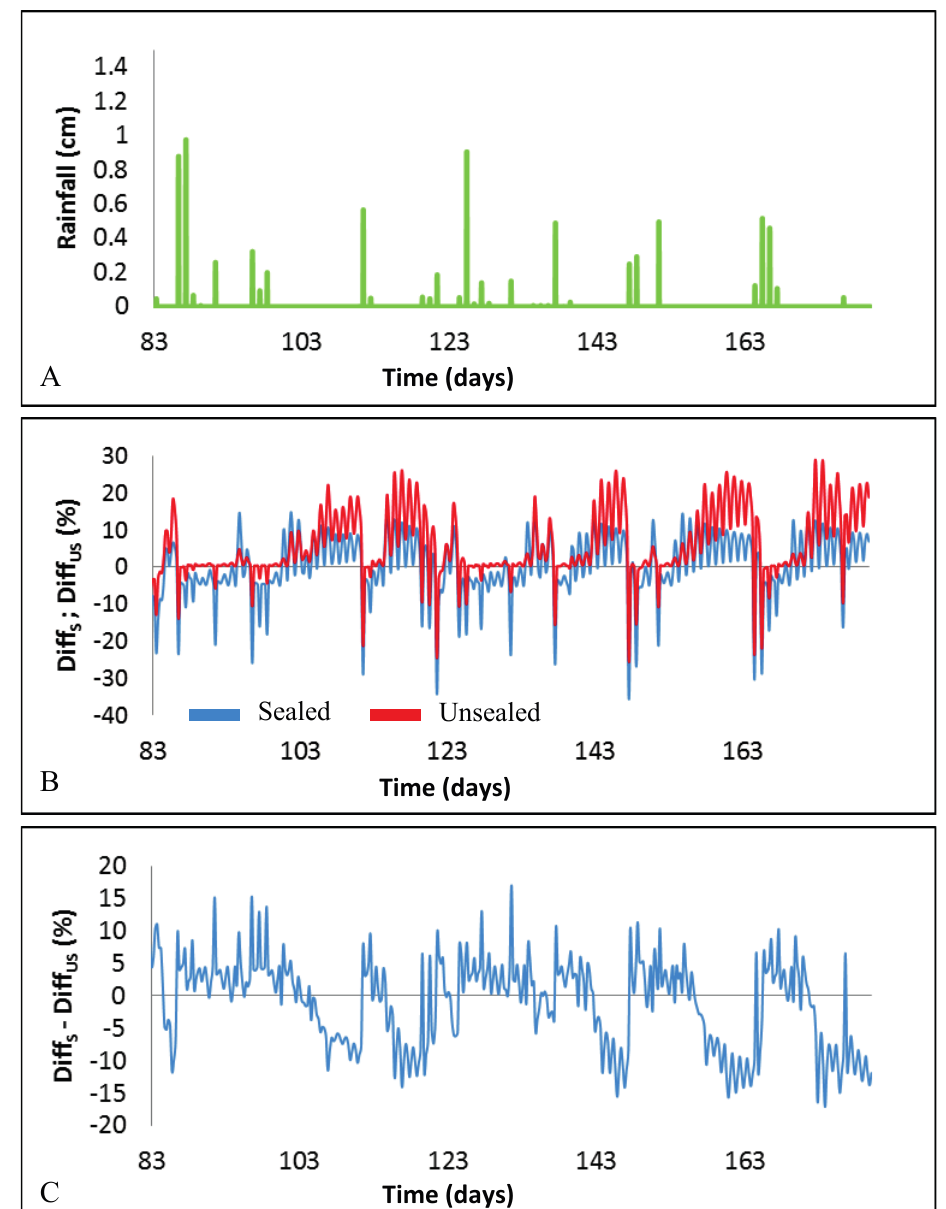
Figure 4. Extract of the 2006–2007 average rainfall season (27.5 cm/y) presenting: ( A ) rainfall data; ( B ) the mean difference between the mean soil-moisture levels in the 0–2 and 0–10-cm soil layers calculated using Equations 4–5. The sealed and unsealed systems are marked in blue and red and denoted by the subscripts, S and US , respectively. ( C ) The net effect of soil sealing on the difference between the